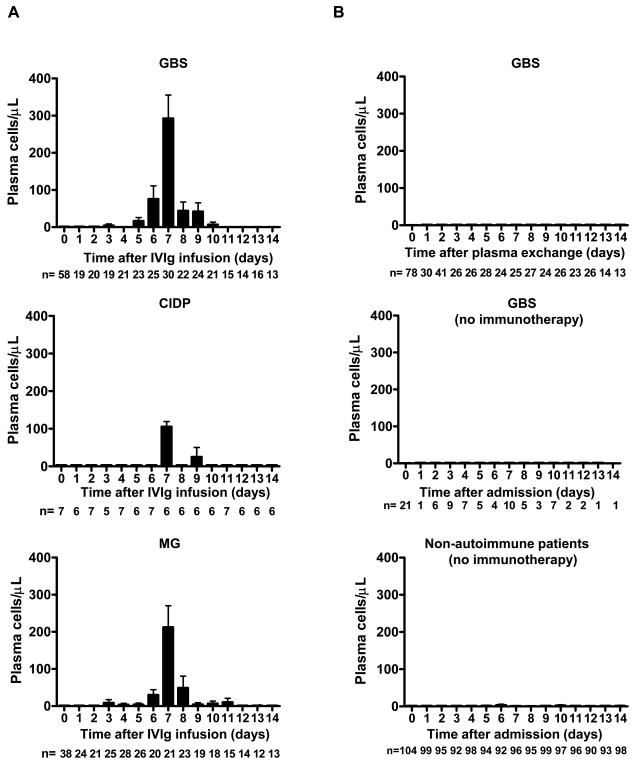
IVIg-related peripheral plasmacytosis peaks on day 7 of treatment in retrospective study.(A) Mean absolute number of plasma cells in IVIg-treated GBS (n = 58, upper panel), CIDP (n = 7, middle panel), and MG (n = 38, lower panel) patients. Severely disabled GBS patients (disability grade 3 or more) received IVIg only, whereas CIDP and MG patients received IVIg and steroids at admission (day0). (B) Mean plasma cell counts in non-IVIg-treated patients over a 14-day period following admission. Severely disabled GBS patients (n = 78, upper panel) were treated with plasma exchange at admission (day0). Moderately disabled GBS patients (disability grade 2 or less, n = 21, middle panel) and non-autoimmune patients (n = 104, lower panel) did not receive any immunotherapy during admission. At each time point, the number of patients with recorded white blood cell count is indicated. Data are mean ± s.e.m.